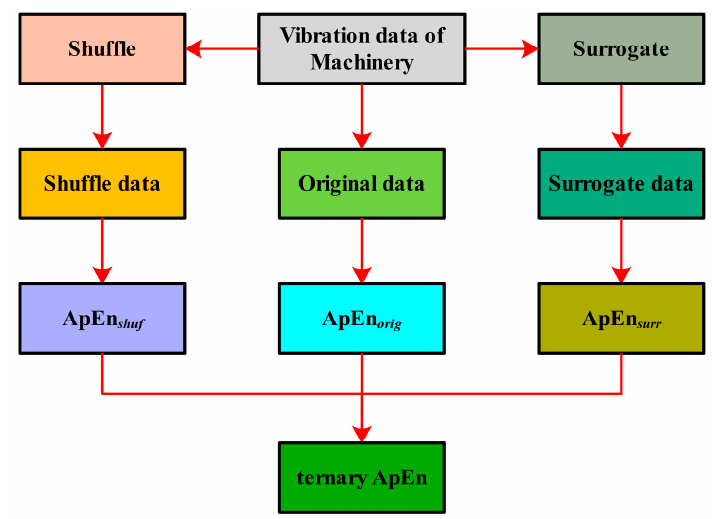
Figure 1. An illustration of the ternary ApEn approach.